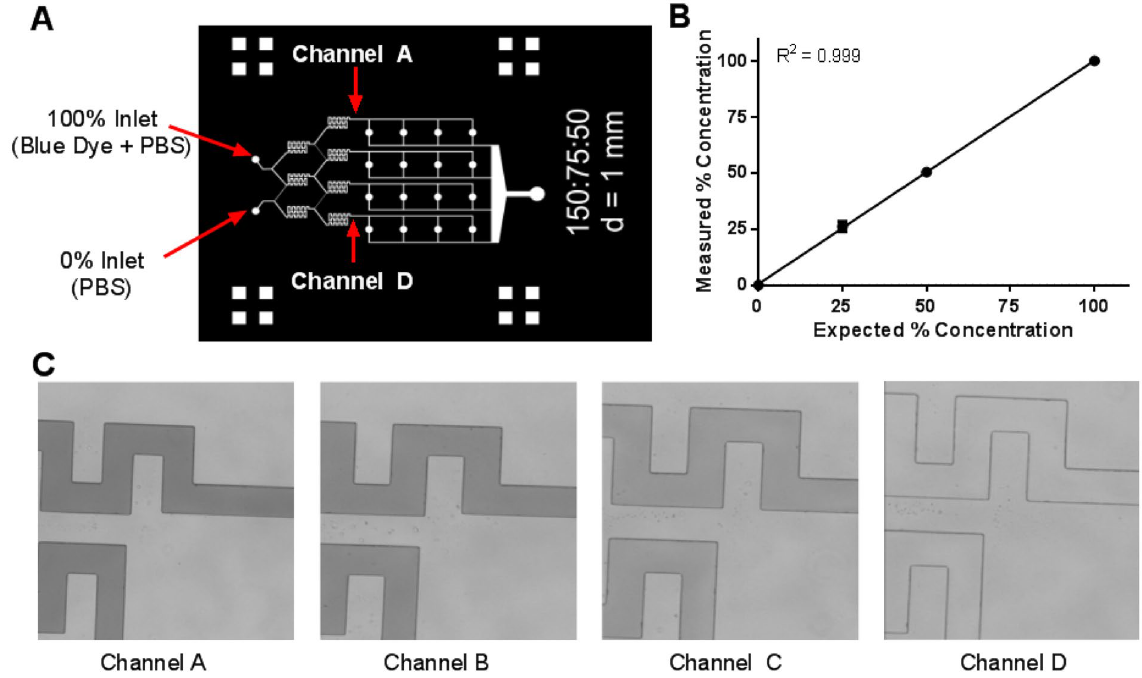
Figure 4. Gradient generation. ( A ) Schematic indicating channels A–D, where the generated concentration gradient was measured. ( B ) Measured concentrations at 1 µL/min flow rate, where channel A contains 100% of the initial concentration of Brilliant Blue FCF and channel D contains 0% Brilliant Blue FCF. ( C ) Representative images of the concentration gradient in each channel at 1 µL/min flow